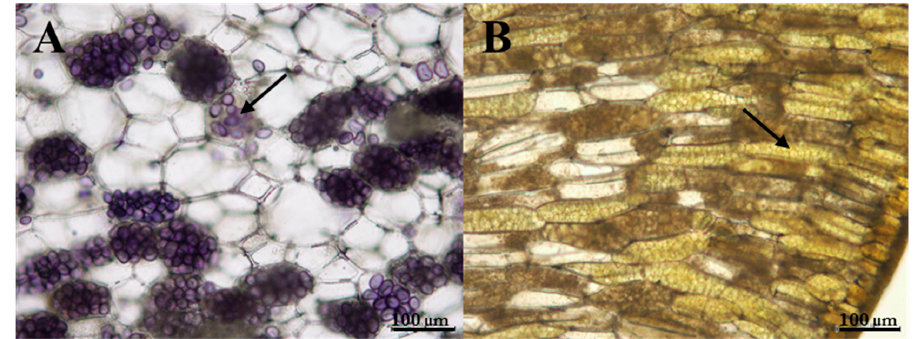
Figure 4. Light micrograph of transversal section of the mung bean cotyledon; arrow indicates the starch grains (Panel ( A )). Light micrographs of transversal section of the soybean cotyledon; arrow indicates the protein vacuoles (Panel ( B )).